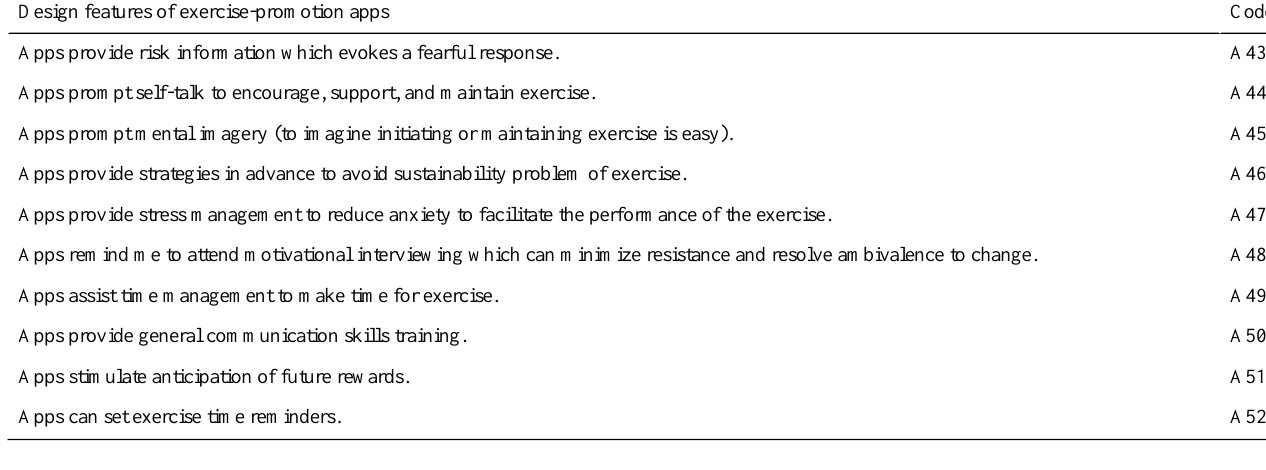
Table 3. The Kano evaluation matrix.